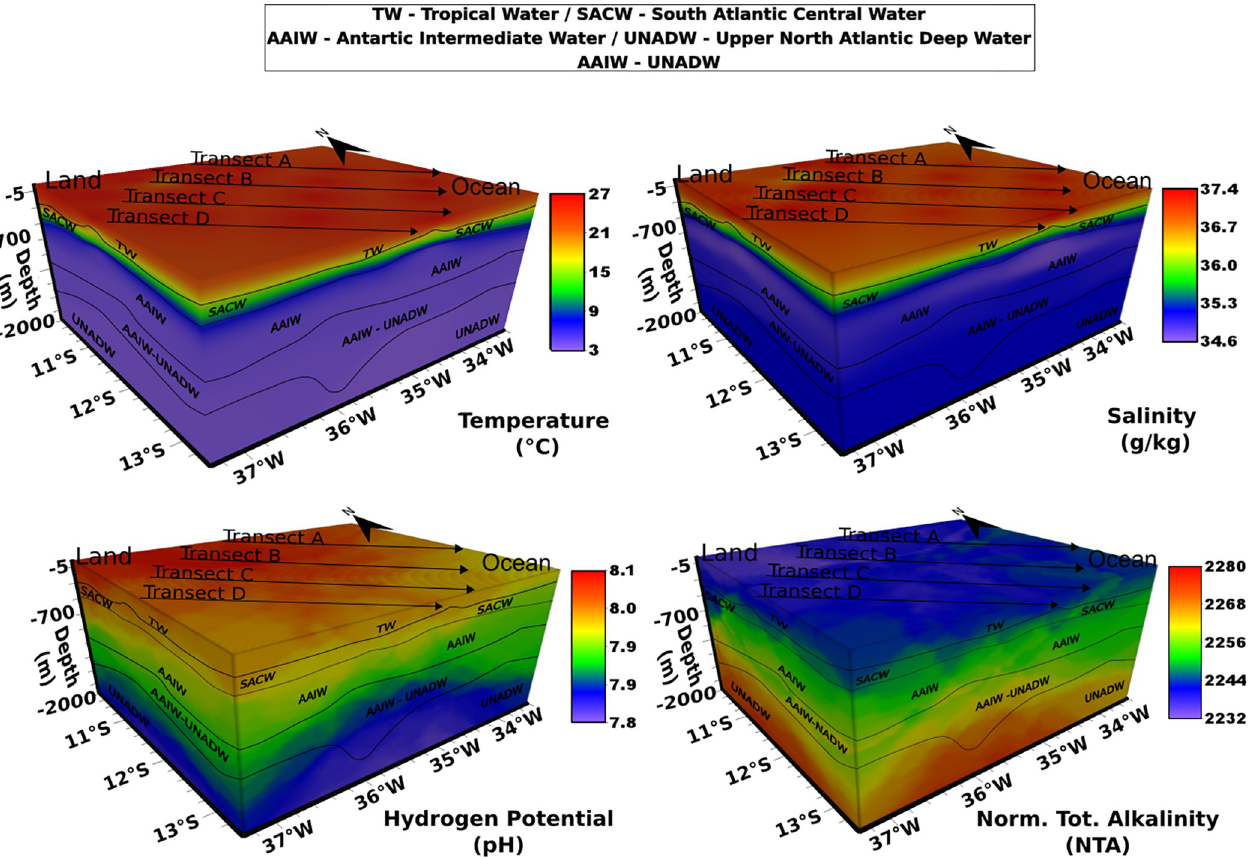
Fig 3. Temperature, Salinity, pH, and Normalized Total Alkalinity (NTA) of the sampling transects, from the internal platform to the abyssal plain.